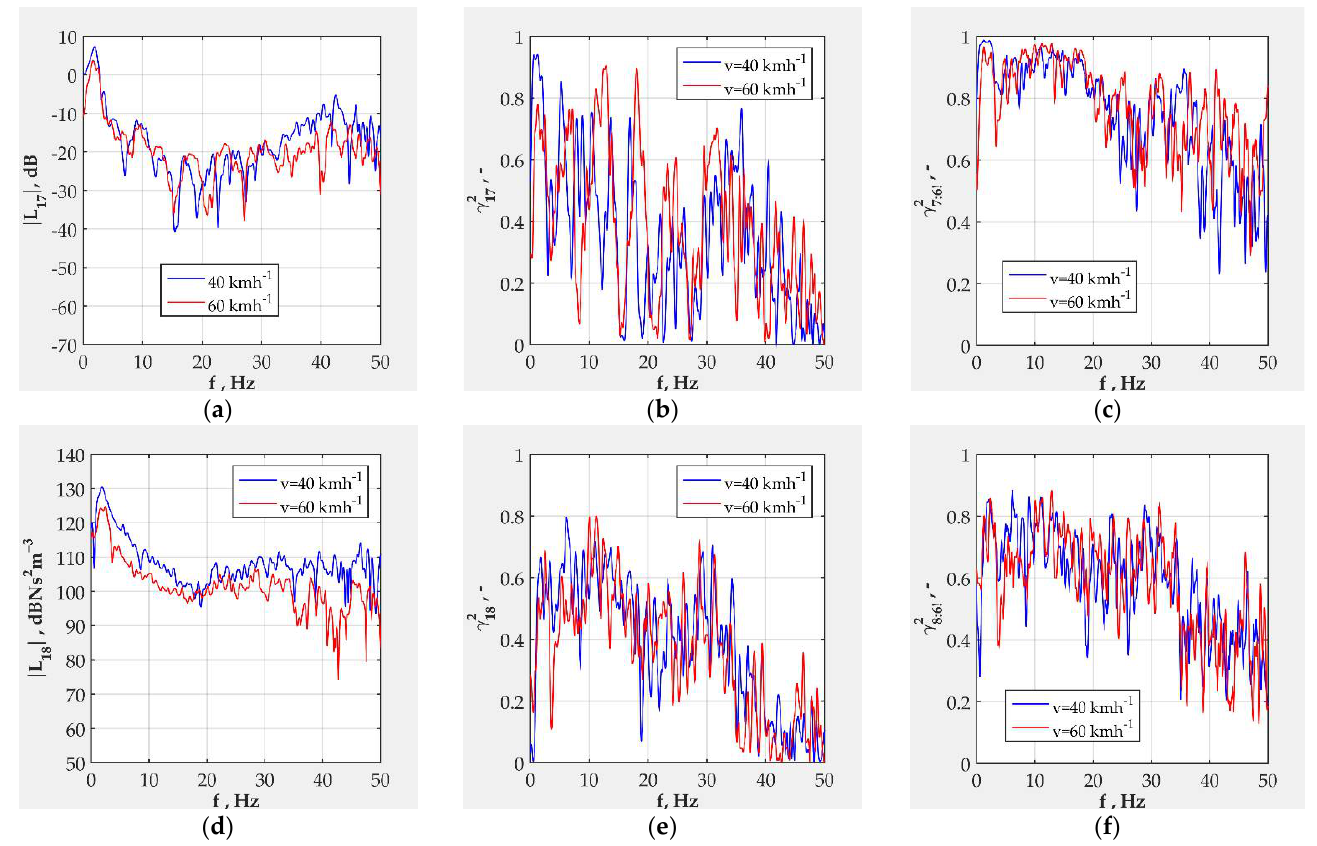
Figure 20. Effects of vehicle speed on: ( a ) magnitude of frequency response function | L 17 | ; ( b ) partial coherence function γ 2 ; ( c ) multiple coherence function γ 2 ; ( d ) magnitude of frequency response function | L 18 | ; ( e ) partial coherence function γ 2 ; ( f ) multiple coherence function γ 2 .